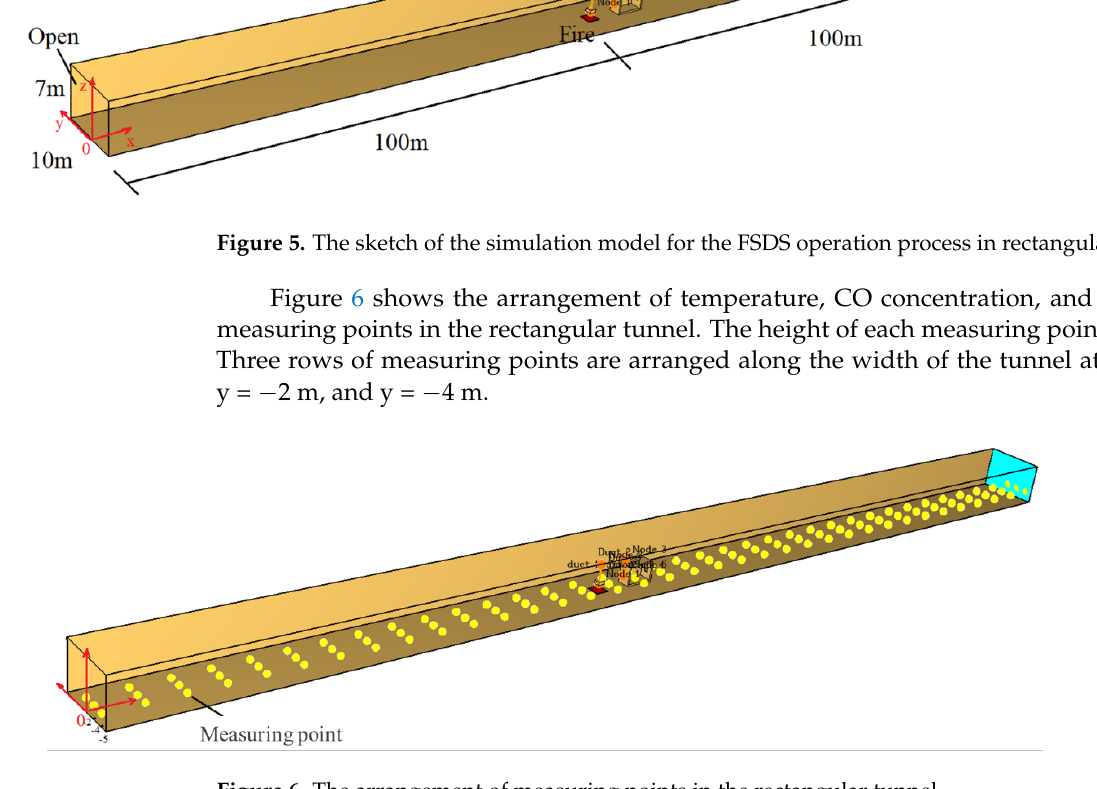
Figure 5. The sketch of the simulation model for the FSDS operation process in rectangular tunnel. Table 5. List of the measured fire environment parameters.